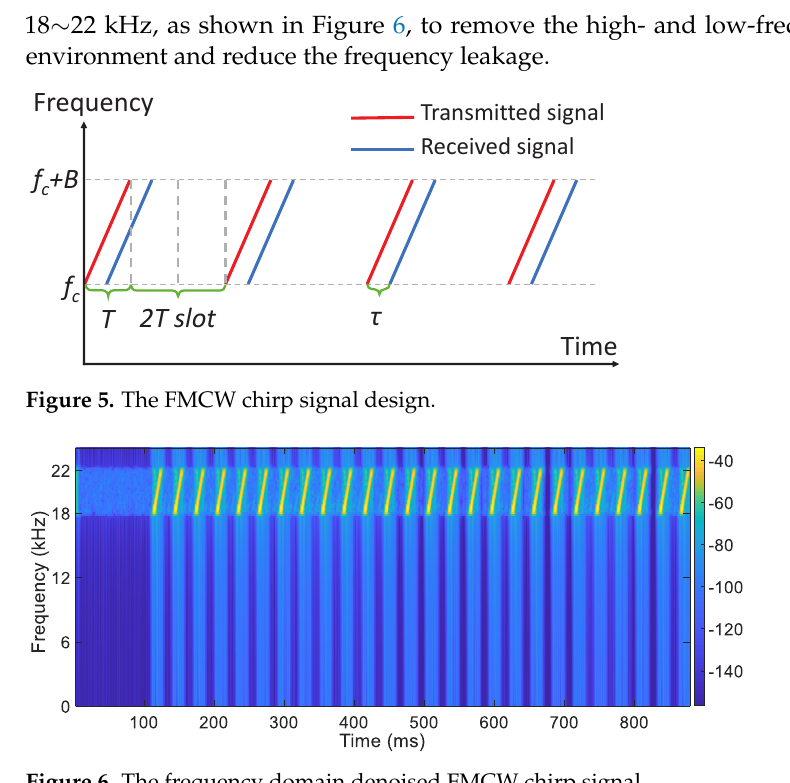
Figure 6. The frequency domain denoised FMCW chirp